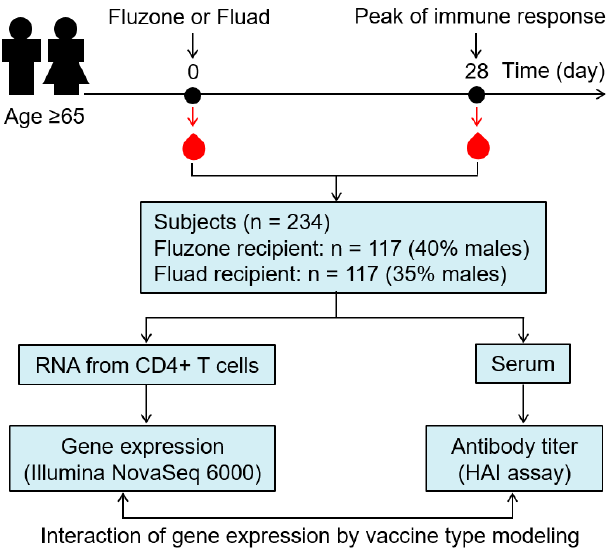
Figure 1. Study design. Of the 234 subjects enrolled (aged ≥ 65), an equal number (n = 117) of subjects was randomly allocated to receive either high-dose Fluzone or MF59-adjuvanted Fluad influenza vaccine. Blood was sampled before immunization (Day 0/baseline) and 28 days after immunization (Day 28). Humoral immune responses against the influenza A/H3N2 virus were assessed in serum using the hemagglutination inhibition assay (HAI). Gene expression was profiled in purified CD4 + T cells isolated from PBMCs. The effect of the interaction of CD4 + T cell gene expression by vaccine type on antibody titer was evaluated using linear regression models (see Methods). Table 1. Demographic and clinical variables of the study cohort. Variables